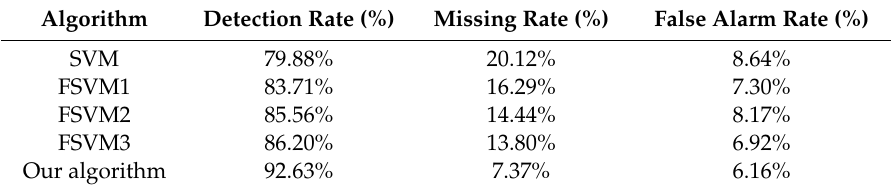
Table 1. Performance comparison on data set